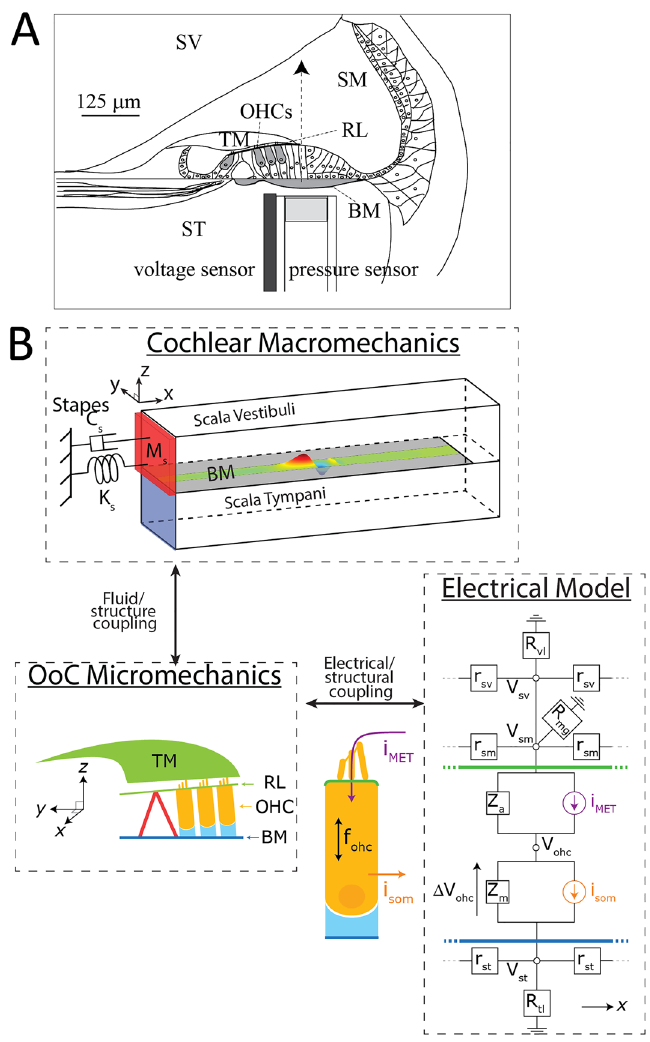
Figure 1. The electrical and mechanical responses of the cochlea to sound are studied using in vivo experiments and a computational model. ( A ) Schematics of the dual sensor probe used to measure fluctuations in the extracellular scala tympani (ST) potential, V st (referred to as the local cochlear microphonics, LCM, throughout the main text), and the acoustic pressure in the ST, P st , at a location close to the basilar membrane (BM). ( B ) Schematics of the physiologically motivated computational model of the cochlea. The model includes a three-dimensional representation of fluid mechanics in the cochlear ducts with bidirectional coupling between the intracochlear fluid and the BM vibrations: the fluid in the ST and scala vestibuli (SV) applies mechanical loads on the BM; the BM vibrations are coupled to the ST and SV pressures via the linearized Euler equation. The BM is part of a micromechanical model of the organ of Corti (OoC) complex that also includes degrees of freedom for the tectorial membrane (TM), and active feedback from OHCs due to electromotility. This micromechanical model of the OoC is coupled to an electrical model that represents the electrical potentials in the SV, scala media (SM), OHC and ST. Vibrations of the OHC hair bundles due to the relative motions of the TM and reticular lamina (RL) result in a mechano-electrical transduction current, I MET (see Eq. (1)), which depolarizes the OHCs. In response to this change in the transmembrane potential, (cid:31) V ohc , OHCs generate an electromotile force, f ohc (see Eq. (2) in “Methods” section), which acts on the BM and RL. Due to the nonlinear relation between hair bundle deflection and transduction current, an IDP is generated when OHCs are stimulated by a two-tone stimulus. Longitudinal (x-direction) cables, of resistance per unit length r st , r sv and r sm are included in the electrical model to represent the spreading of electrical current in the cochlear ducts; these cables are essential for the predictions of the key characteristics of the LCM in the experiments. Tables S1 and S2 in in Supplementary Information list the parameters seen in the Figure and provide the numerical values of these